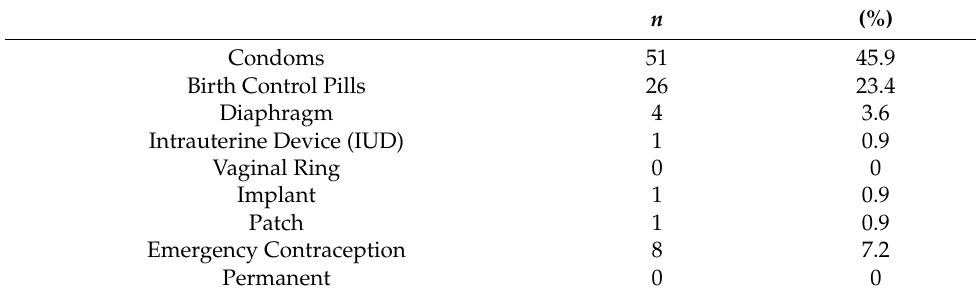
Table 9. Types of contraceptives used by 1.5 generation migrants in